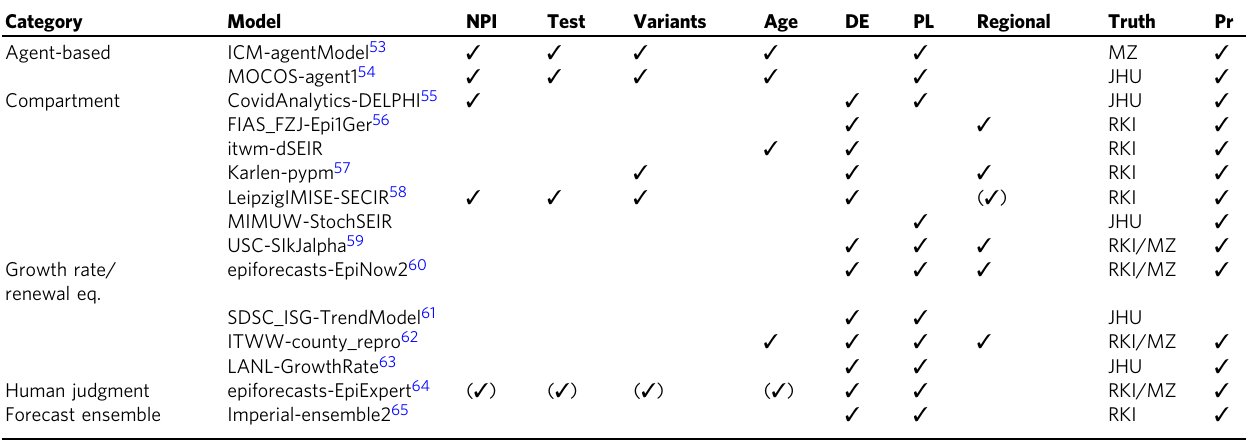
Table 1 Forecast models contributed by independent external research teams. Category